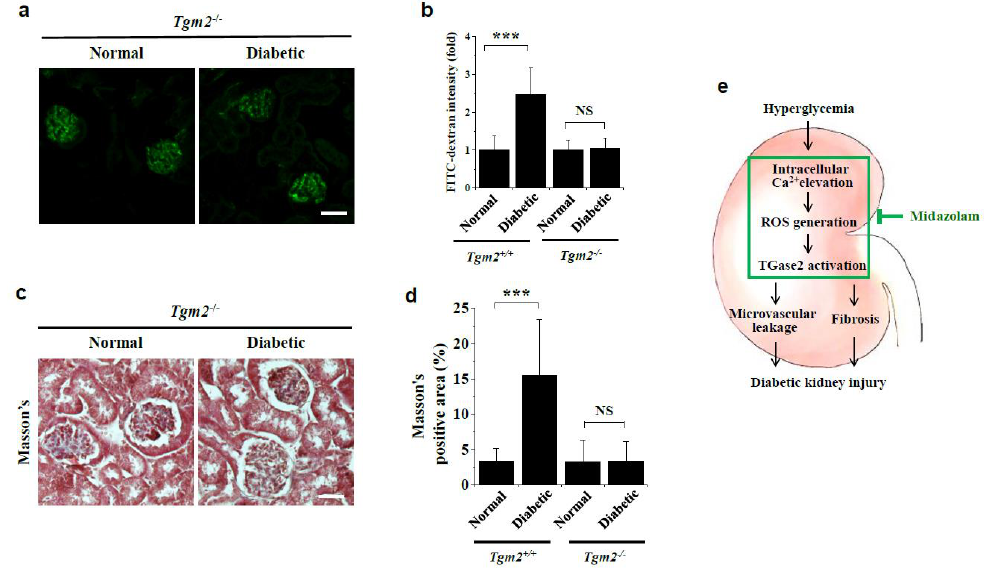
Figure 8. Analysis of vascular leakage and renal fibrosis in kidneys of diabetic Tgm2 −/− mice and a schematic diagram depicting the effect of midazolam on the kidney injury in diabetic mice. ( a , b ): Vascular leakage of FITC-dextran is not observed in kidneys of normal or diabetic Tgm2 −/− mice ( n = 6). Representative fluorescence images of FITC-dextran are shown ( a ). Scale bar, 50 μ m. Vascular leakage was quantified by measuring the fluorescence intensity of FITC-dextran in the renal glomerulus ( b ); Tgm2 +/+ data are from Figure 2d. ( c , d ): Renal fibrosis is not detected in kidneys of normal and diabetic Tgm2 −/− mice, as assessed by Masson’s trichrome staining (n = 6). Representative images of renal tissues stained with Masson’s trichrome are shown ( c ). Scale bar, 50 μ m. Areas positive for Masson’s trichome staining ( d ); Tgm2 +/+ data are from Figure 7c. *** p < 0.001; NS, non-significant. ( e ): Schematic model depicting the beneficial effect of midazolam on hyperglycemia-induced kidney injury in diabetic mice.